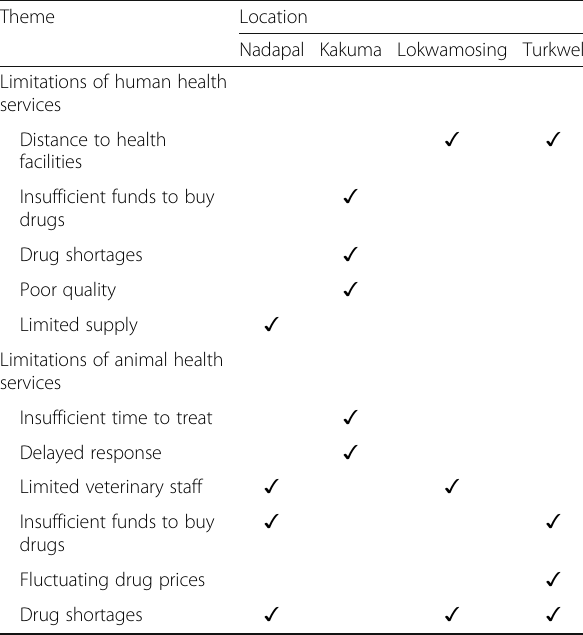
Table 4 Limitations of human and animal healthcare identified by pastoralists in